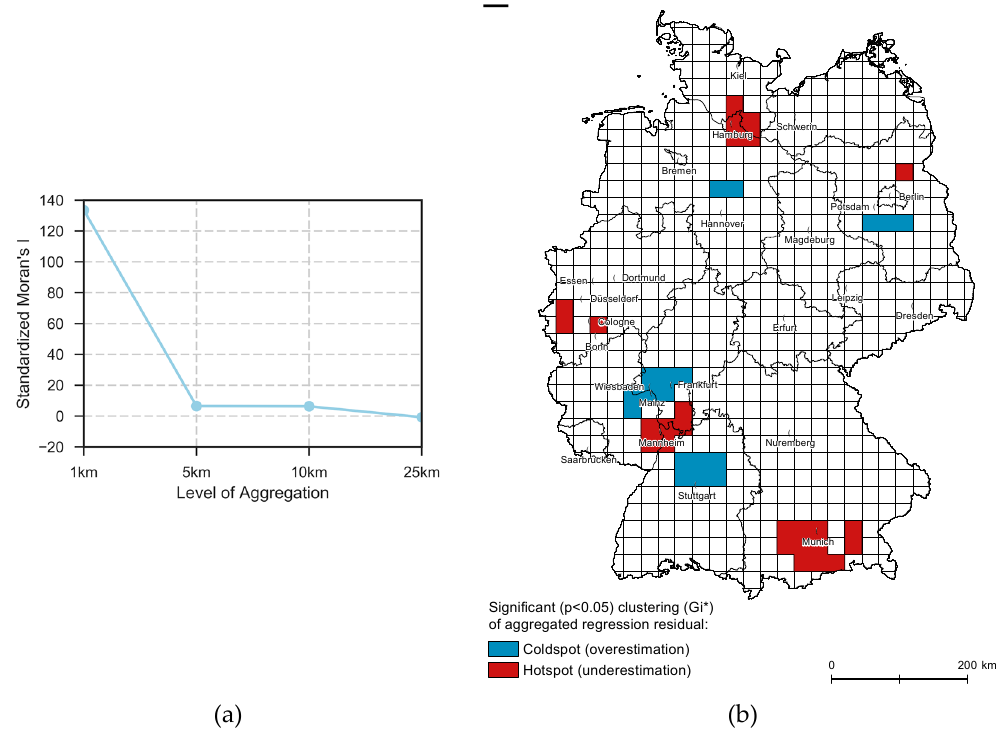
Figure 6. ( a ) Standardized Moran’s I of regression residual aggregated at different levels of aggregation; ( b ) Significant clustering of regression residual aggregated at 25 km grid.